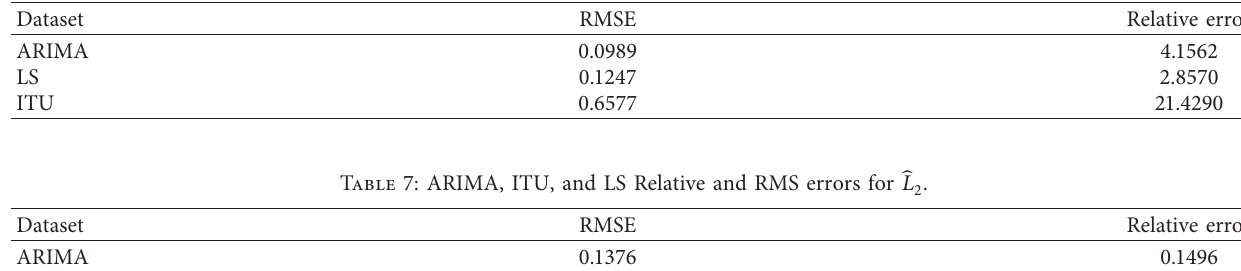
Table 6: ARIMA, ITU, and LS Relative and RMS errors for 􏽢 L